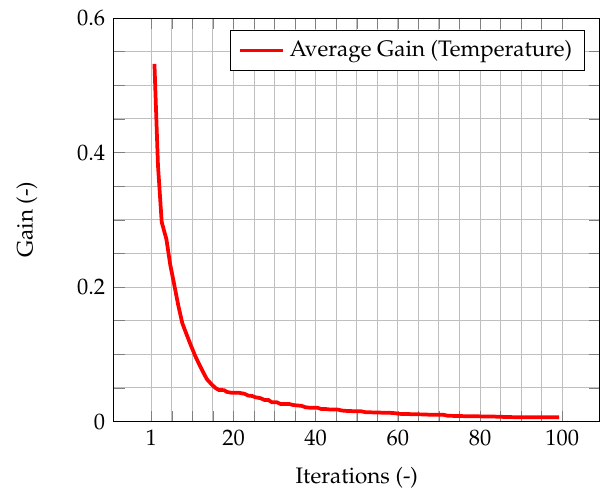
Figure 14. Time evolution of the average Kalman gain for temperature, highlighting its exponential-like behavior and the stationary value reached at convergence.